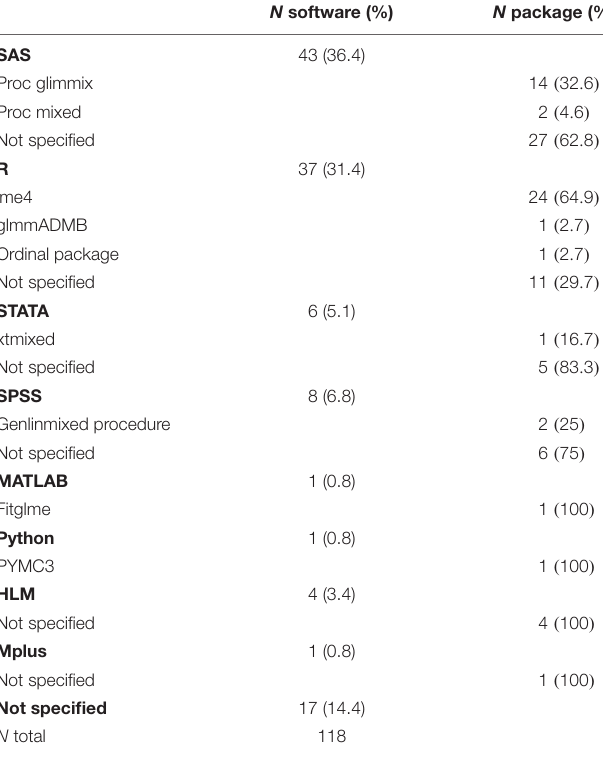
TABLE 6 | Statistical software and specific packages used in the 118 GLMM N total